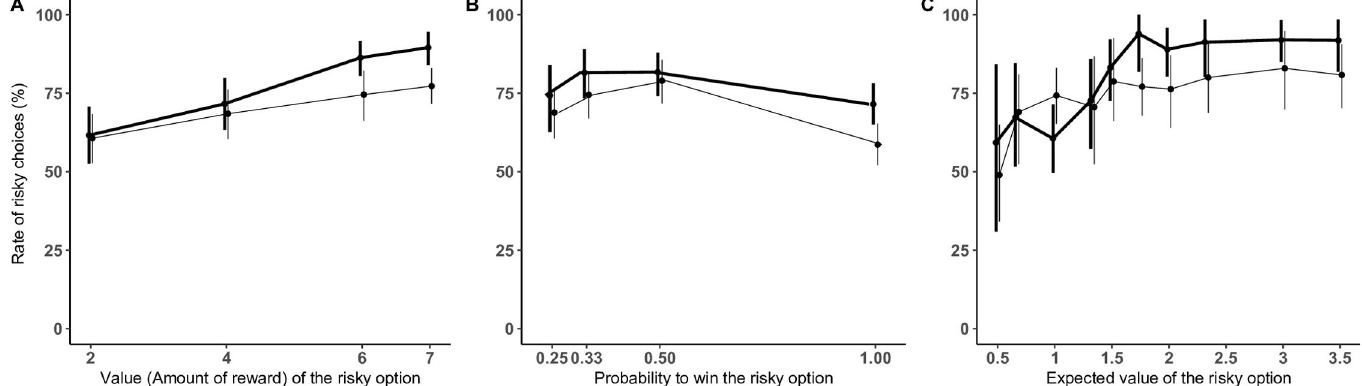
Fig 3. Results of Experiment 2. Mean percentage of trials where subjects selected the risky option according to the value of the risky option (A) the probability to win (B) and the expected value of the risky option (C) for the high-valued reward (grapes, in thick line) and low-valued reward (vegetables, in narrow line). Error bars indicate 95% confidence intervals. Only trials with P < 1 were considered for (C).